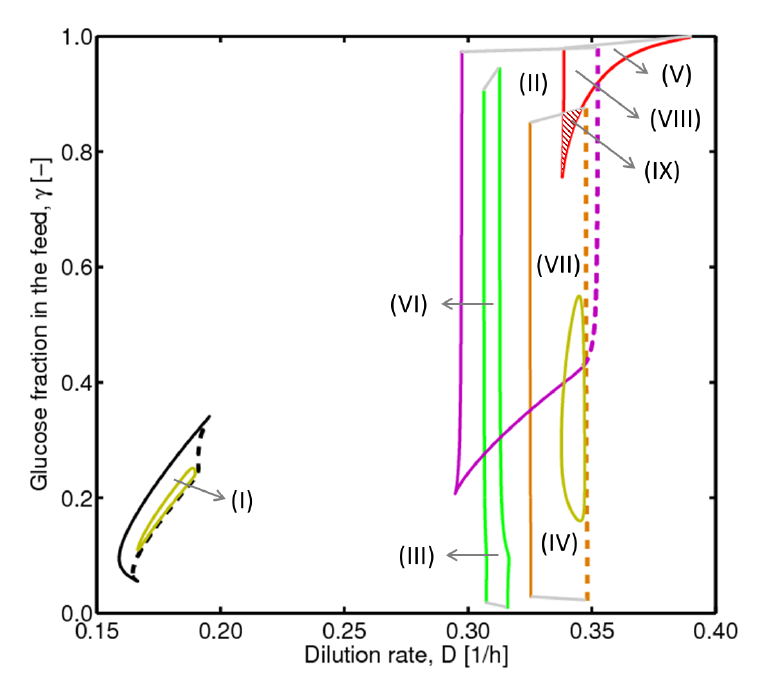
Figure 8. A global bifurcation diagram in the D − γ space when x